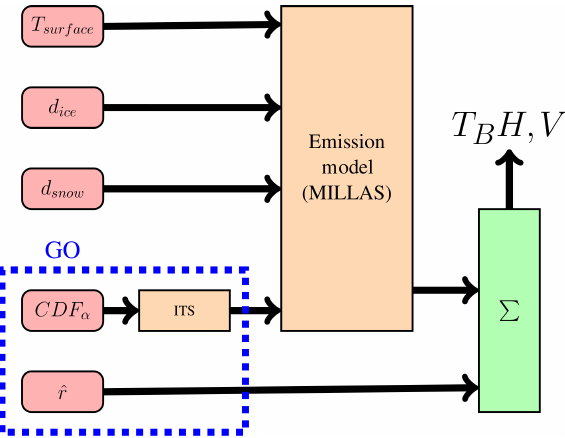
Figure 7. Effects of the large-scale surface roughness on the bright- ness temperature of sea ice, simulated with the geometrical rough- ness model. Vertical polarisation is in red, and horizontal polarisa- tion is in blue. The black dashed lines mark the T B for the spec- ular surface. The surface roughness parameter s α varies between 2 and 20; the thicker the line the higher the s α . The inputs for the MILLAS emissivity model are kept constant: T surface = 260K, d ice = 1 . 42m, and d snow = 0 .